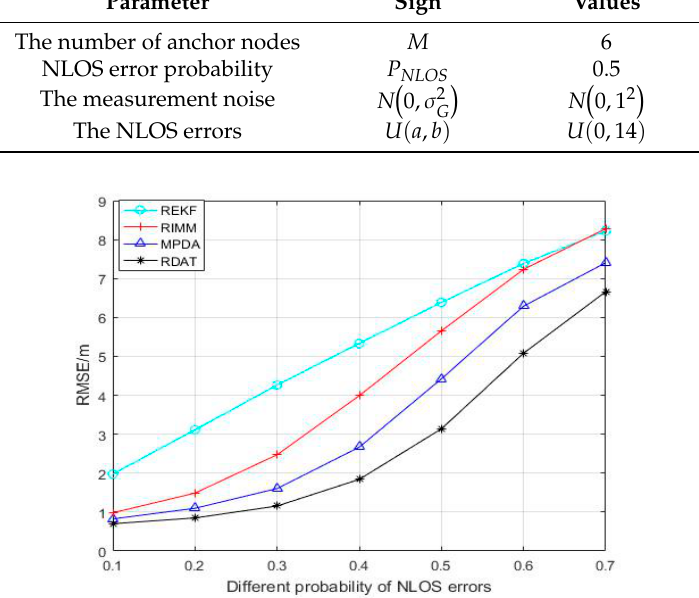
Figure 7. Performance comparison between RIMM, REKF, MPDA, and RDAT with the probability of (cid:16) (cid:17) NLOS errors P NLOS , N 0,1 2 and U ( 0,14 ) .